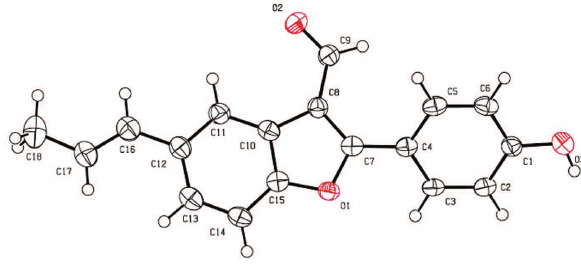
Table 1: Data collection and handling.